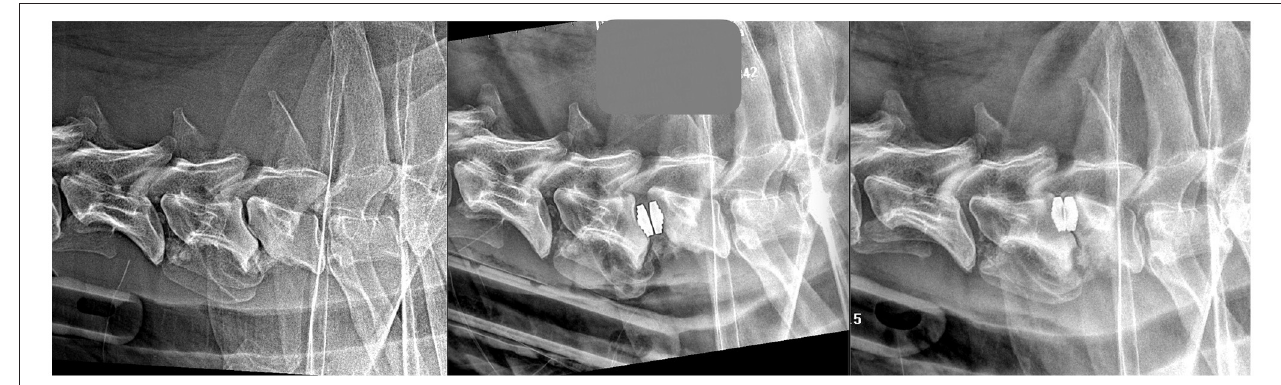
FIGURE 4 | Latero-lateral radiographs of the same dog before a PD surgery (left image), at 30 days post-op (middle image) and at 90 days post-op (right